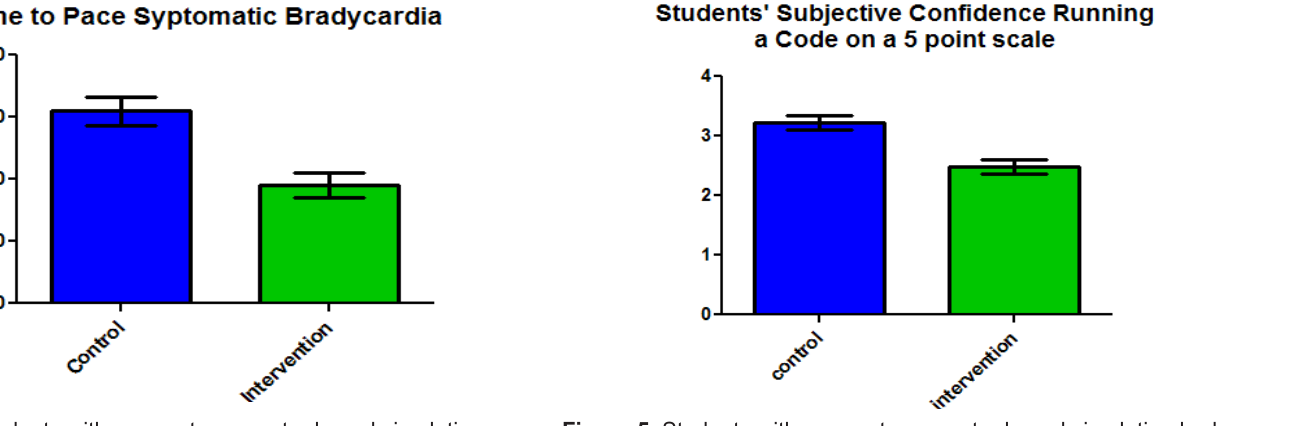
Figure 3. Students with access to computer based simulation paced Symptomatic Bradycardia in the ACLS Megacode 60 seconds faster than students without access [t(63)=3.71, p<0.5].